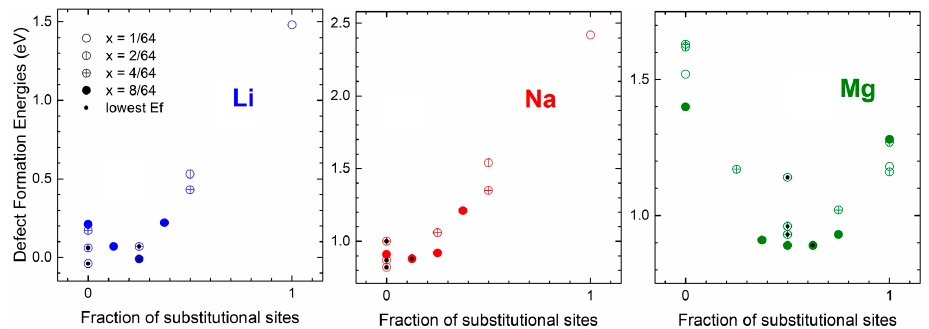
systems at different Li/Na/Mg concentrations ( x = 1/64—empty circles, 2/64—circles with one vertical bar, 4/64—circles with two perpendicular bars, 8/64—full circles) and for different repartitions of tetrahedral (interstitial) and substitutional sites. The defect formation energies are plotted against the fraction of substitutional sites. The lowest configuration for each concentration is indicated with a black dot. Reprinted with permission from [37], © (2017) Elsevier. black dot. Reprinted with permission from [37], © (2017)